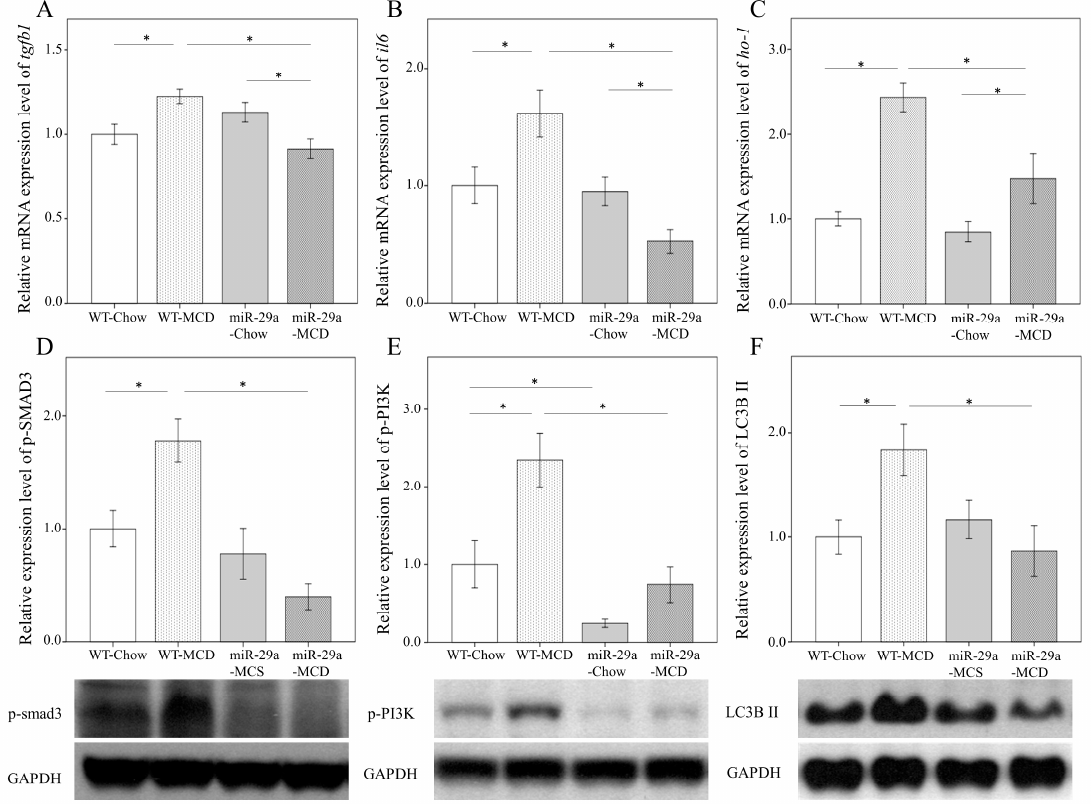
Figure 4. Overexpression of miR-29a reduces cytokines and autophagy in MCD-diet mice. Comparison of the mRNA expression of TGF- β 1 ( A ), IL-6 ( B ), and HO-1 ( C ), as well as the protein expression of p-SMAD3 ( D ), p-PI3K ( E ), and LC3BII ( F ) in WT and miR-29Tg mice livers. Data from six to eight samples per group are expressed as mean ± SD. * indicates a p < 0.05 between the